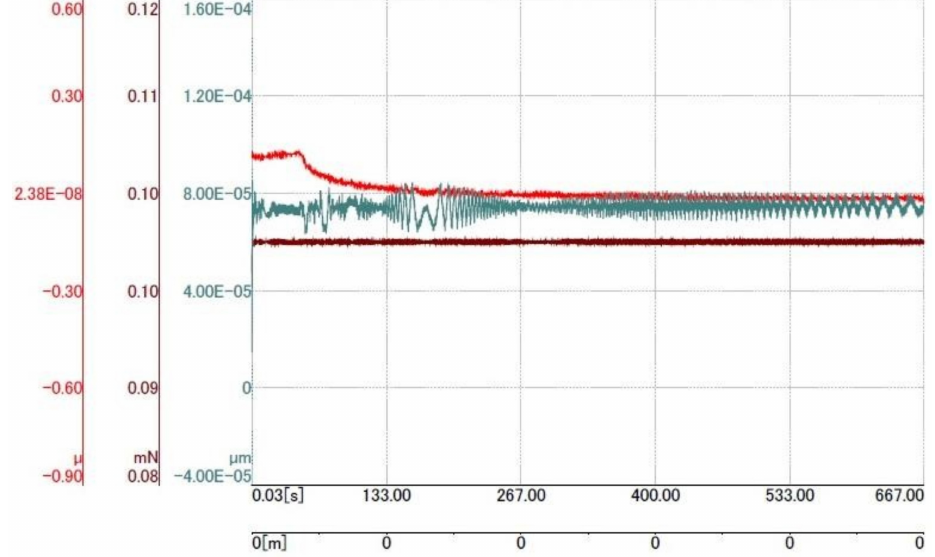
Figure 7. Results of wear tests for the chitosan of DD 87% sigma coating: red color—change in friction coe ffi cient with test time, green color—change in penetration depth ( µ m), and brown color—load force, which was constant during the